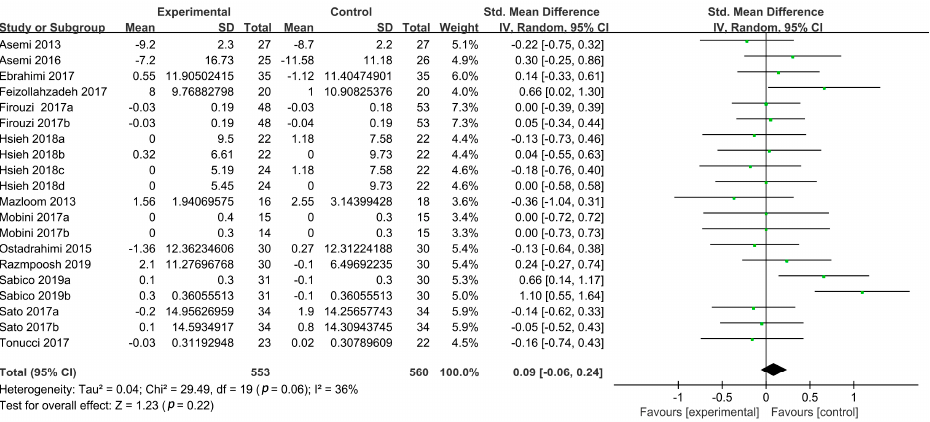
Figure 6. Forest plot of the effects of probiotics on HDL-C concentrations.